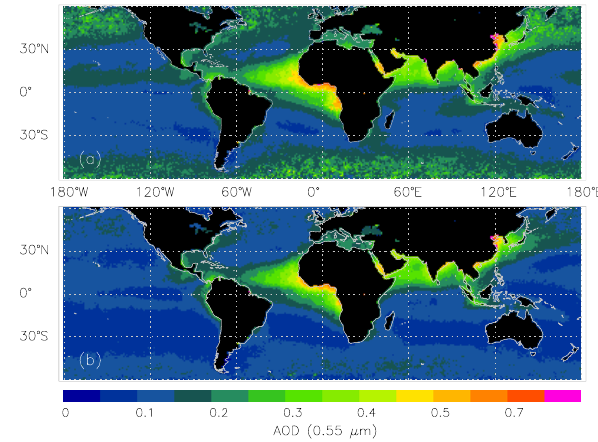
Fig. 1. (a) Yearly mean aerosol optical depth (AOD) plot using the operational over-water Terra MODIS aerosol product for year 2007; (b) Similar to (a) except using the DA quality over-water Terra MODIS aerosol